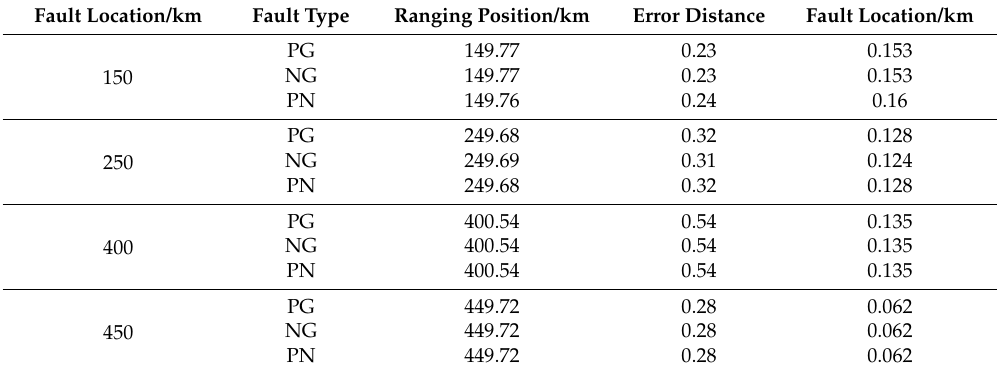
Table 2. Distance measurement results of a two-segment line with different fault points and fault types.